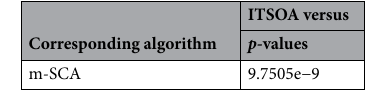
Table 4. The competitive results of Wilcoxon’s test.